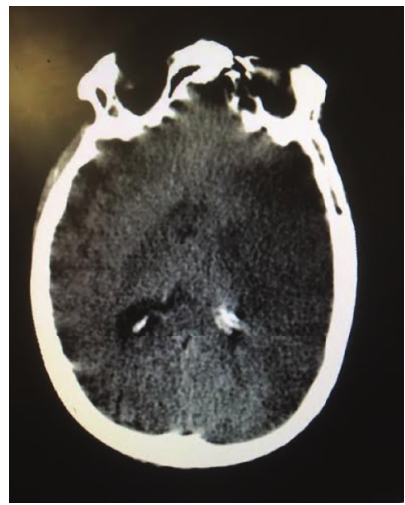
Figure 2: High density within left middle cerebral artery territory, corresponding to the site of arterial occlusion.